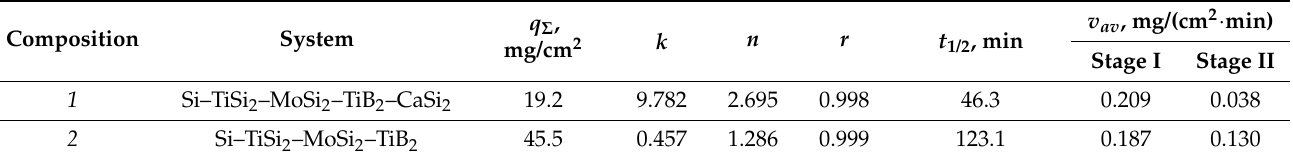
Table 2. Characteristics of the kinetics of compact oxidation at 1650 ◦ C after total isothermal holding for 5 h. q Σ Composition System